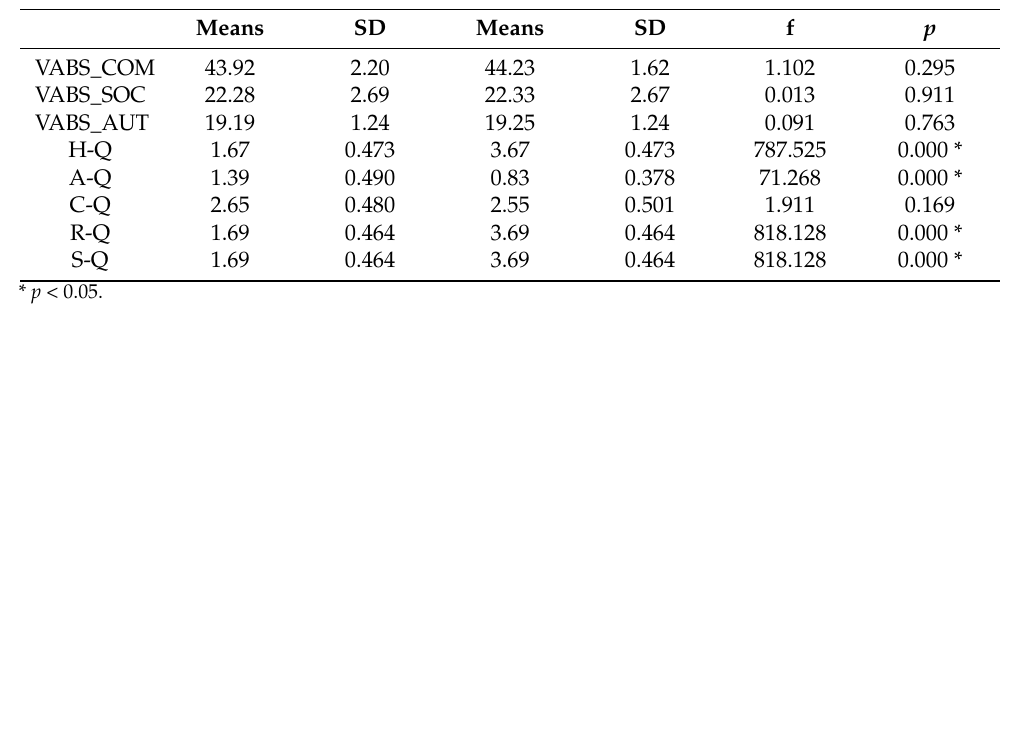
Table 2. Comparisons to T1 and T2 .